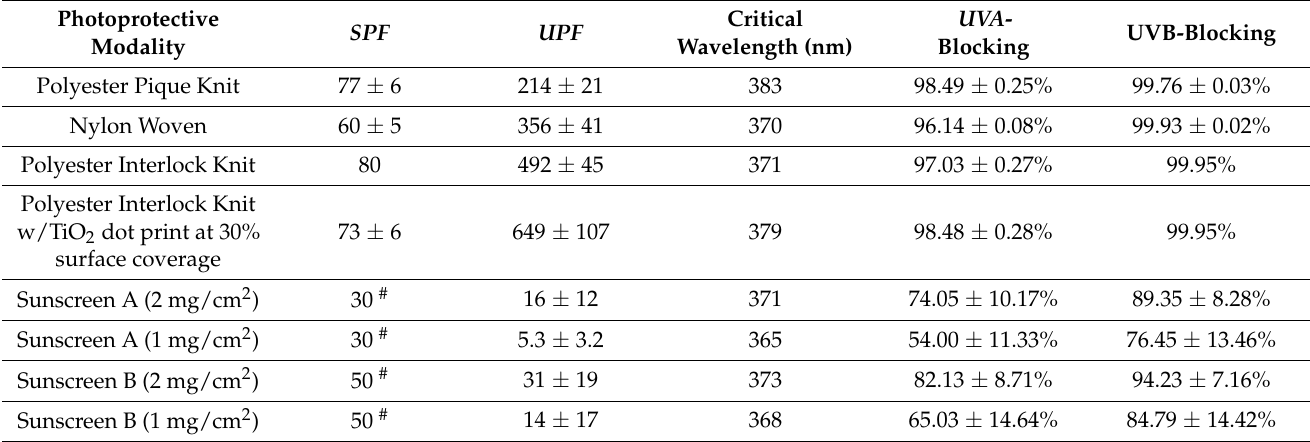
Table 2. Measured UPF , SPF , Critical Wavelength, UVA and UVB blocking capabilities of studied fabrics and sunscreens. ** Each fabric SPF is the average of measurements across three subjects of Fitzpatrick skin types I, II, and III to maximize the human variation studied. Each UPF quantity is an average of 5 unique measurements per textile and 10 unique measurements per sunscreen at each of the two